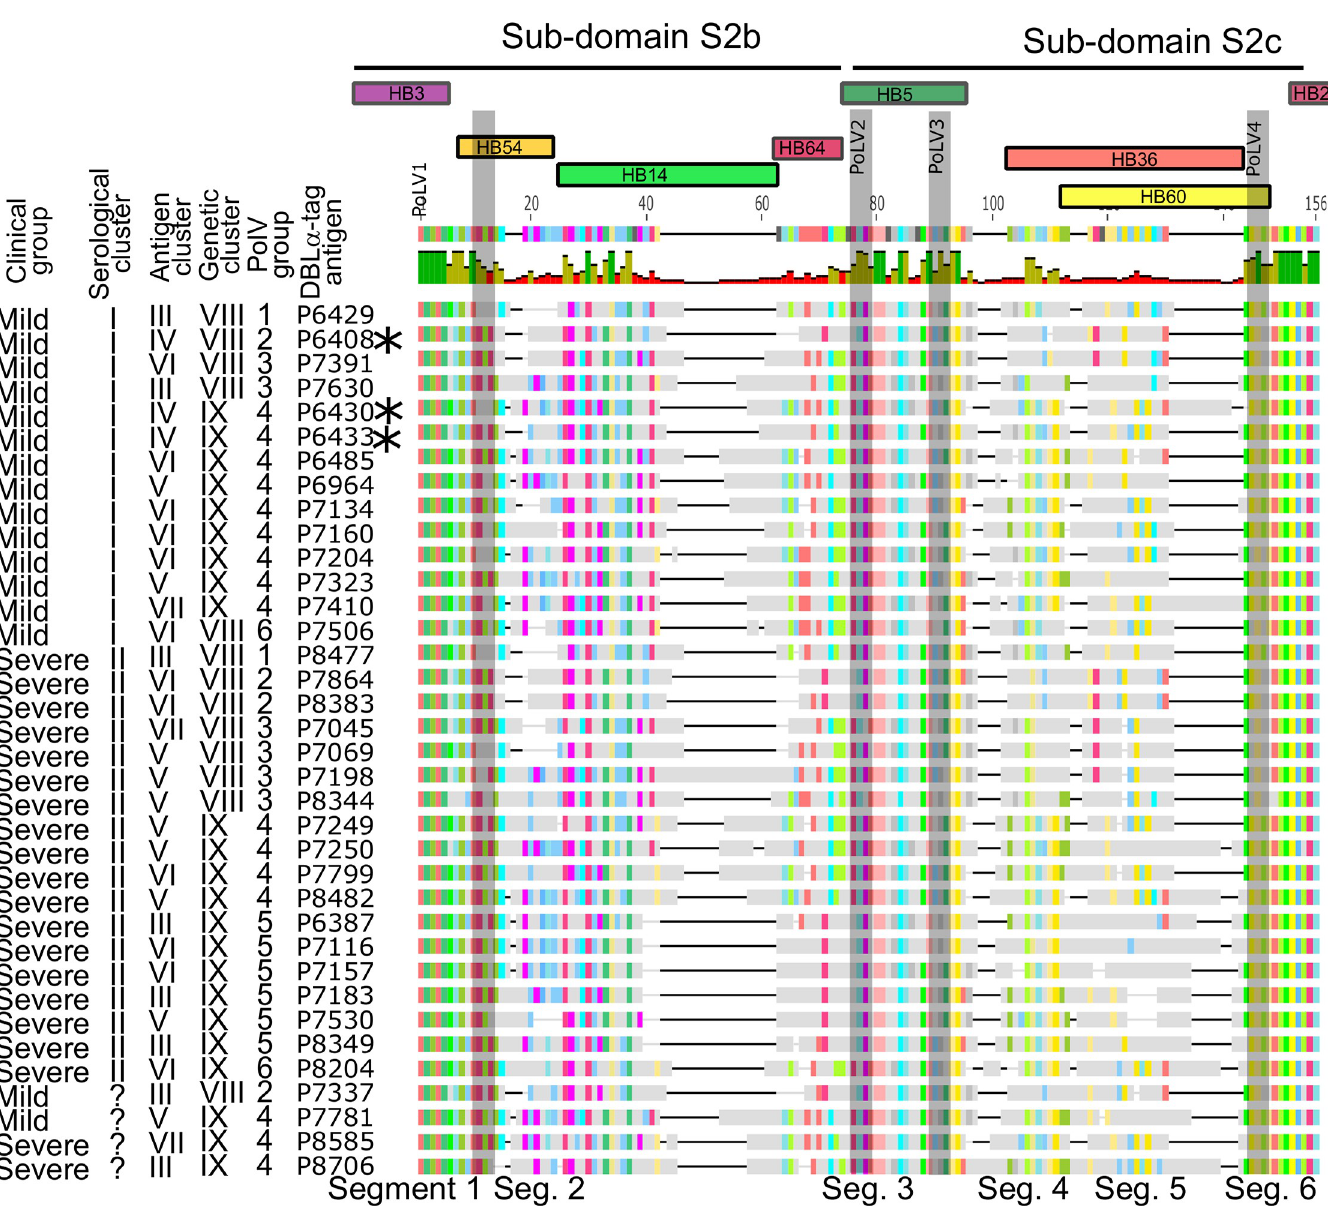
Fig 7. Amino acid sequence alignment of the DBL α -tag recombinant proteins. Coloured residues indicate identity with the consensus sequence which is shown at the top; grey residues indicate differences from the consensus. Dashes indicate non-presence of the consensus residue. The sequence divides into six segments of moderate homology (black text below figure) and into two sub-domains, S2b and S2c as defined in ref. [9] (black horizontal lines at top). Positions (window midpoints) that best define serological and genetic clusters, respectively, are shown with vertical arrows, corresponding to those shown in Fig 6A and 6B, respectively. Parasite isolates, their clinical group, cluster membership and PoLV groups are indicated in black text to the left of the figure. Coloured blocks at the top of the figure show homology blocks (HB) as defined by Rask et al. (2010). The most highly conserved HBs across the global population are shown at the top: below these are less conserved HBs that showed significant associations with disease severity, serological cluster (HB14, HB54 and HB64) and genetic cluster (HB36 and HB60) in this study (Table 1).